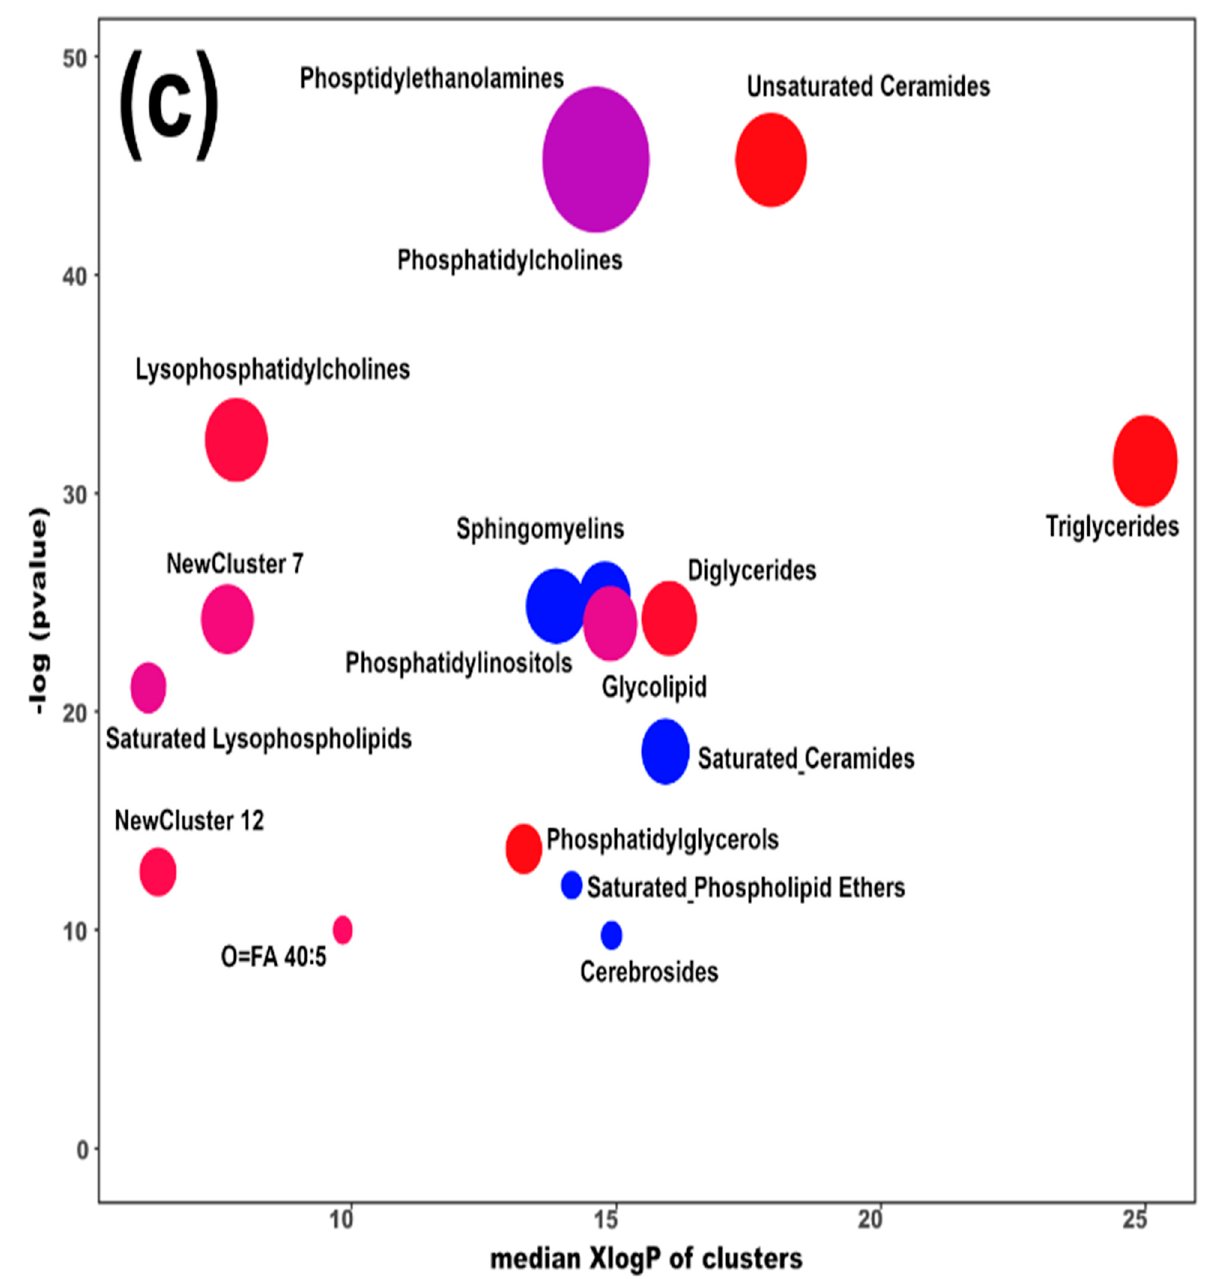
Figure 4. Heatmap ( a ), correlation plot ( b ), and ChemRICH set enrichment statistics plot ( c ) of the concentration of the fatty acids quantified by UHPLC-HRMS/MS in giant panda serum samples, which show a statistically significant difference between groups. In the ChemRICH set enrichment statistics plot, each node reflects a significantly altered cluster of molecules. Enrichment p-values are calculated through the Kolmogorov–Smirnov test. Node sizes represent the total number of metabolites in each cluster set. The node color scale shows the proportion of increased (red) or decreased (blue) compounds in the High bamboo shoot consumption group compared to the Normal group. Purple-color nodes have both increased and decreased molecules.